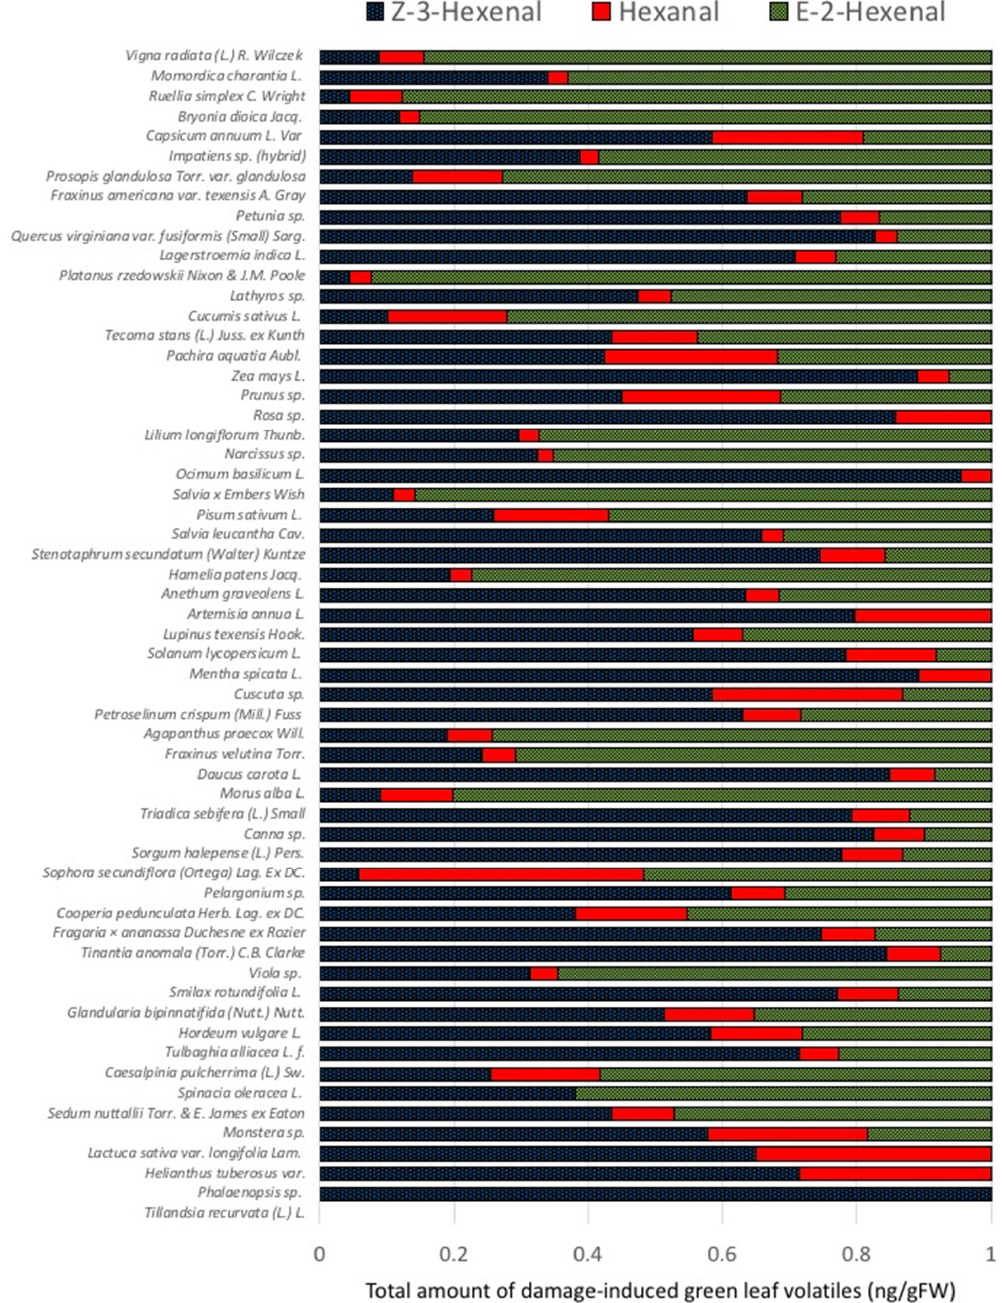
Figure 3. Proportions of GLVs emitted from damaged leaf tissue of different plant species. Shown is the relative abundance for ( Z )-3-hexenal, hexanal, and ( E )-2-hexenal as a percentage. Plants are organized as shown in Figure 1. Results for each plant species are averages from at least three biological replicates.